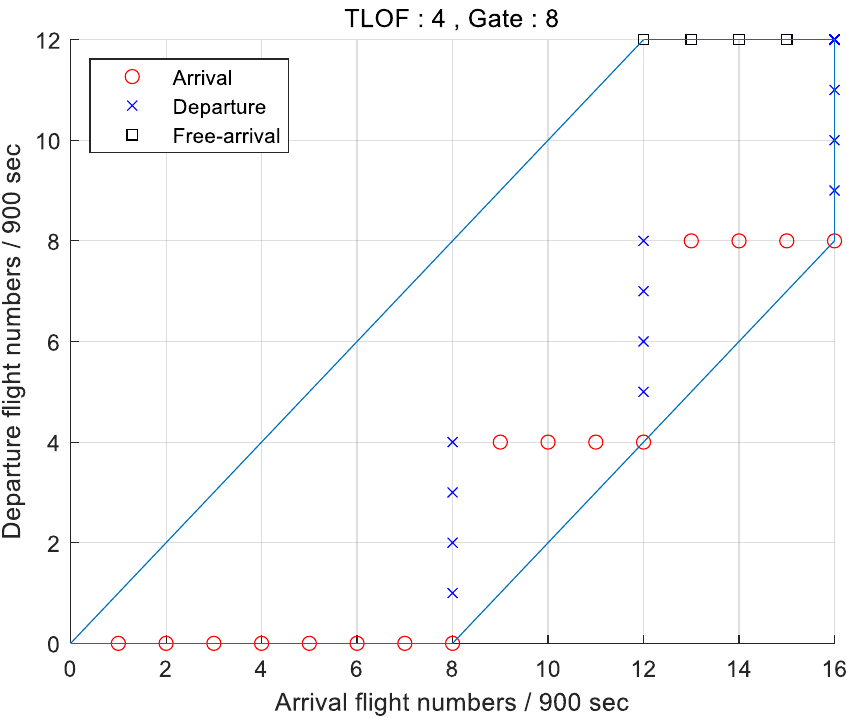
Figure 36. Capacity of a linear topology for the expanded Gimpo Airport parking lot that complies with the EASA’s new regulations.